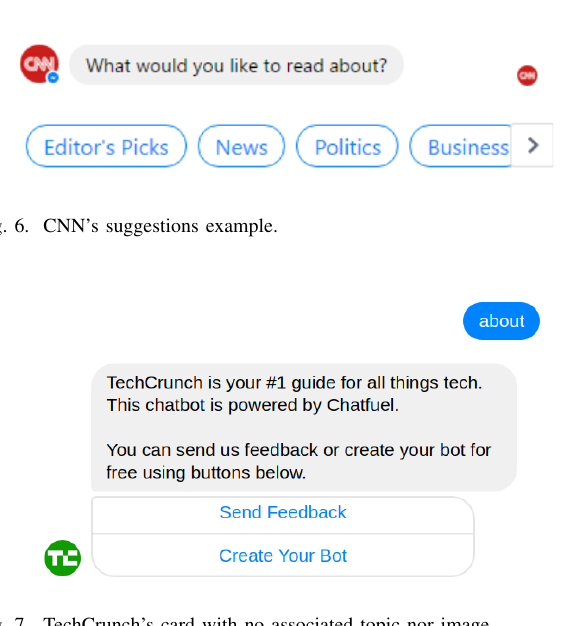
Fig. 7. TechCrunch’s card with no associated topic nor image.